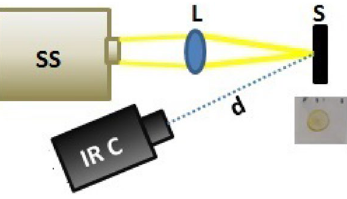
Figure 11. Set up of the thermographic